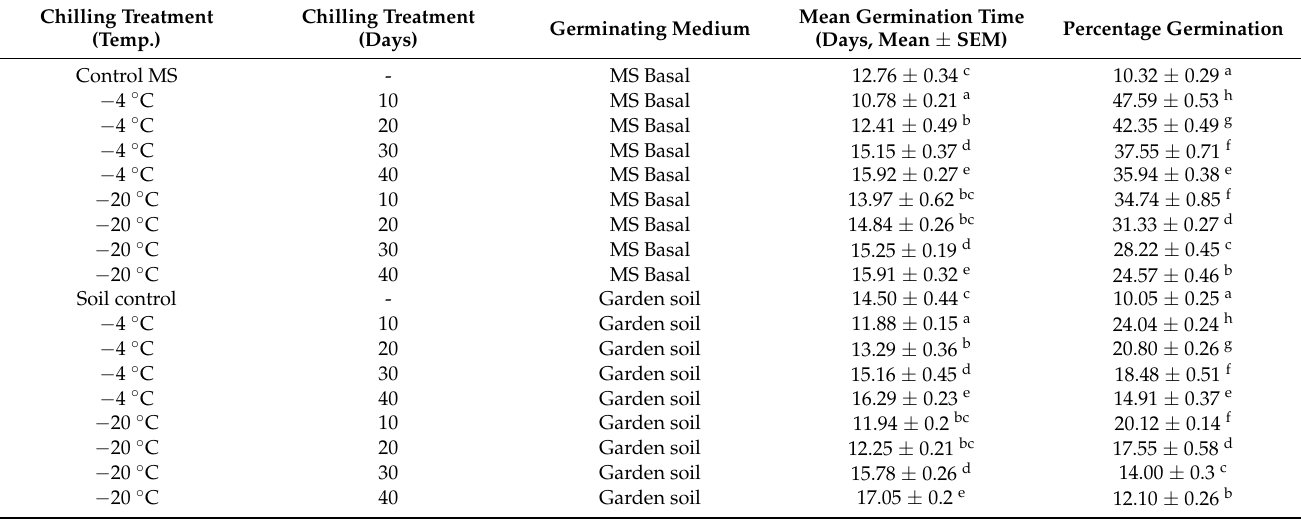
Table 1. Effect of different chilling treatments on seed germination in MS basal medium and garden soil (garden soil, sand, and vermicompost at 1:1:1). Chilling Treatment